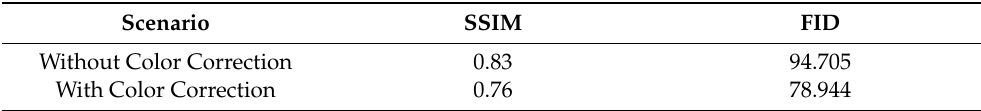
Table 5. Result of cGAN-TV with and without color correction.